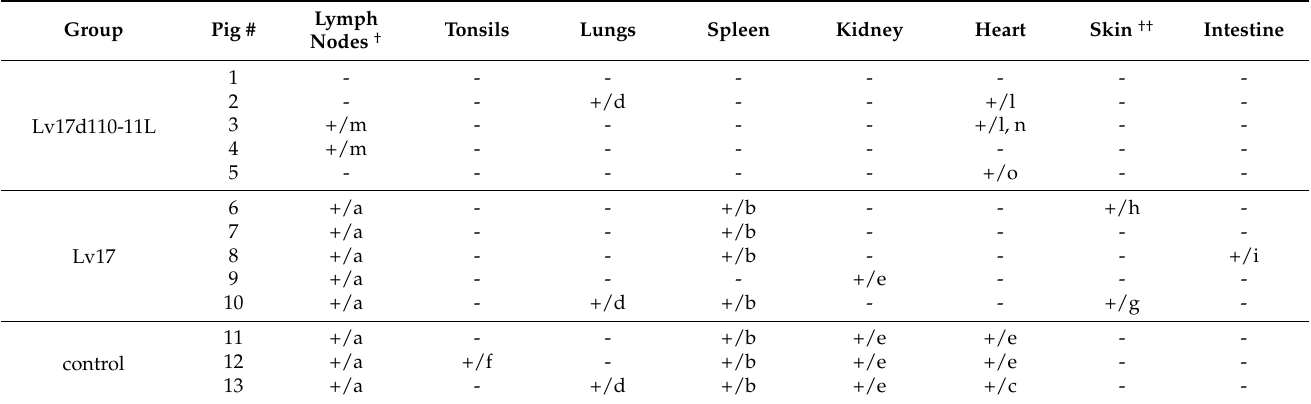
Table 6. Description of the macroscopic lesions observed in different groups injected with Lv17/WB/Rie1/d110-11L and Lv17/WB/Rie1 of African swine fever virus (ASFV) and challenge- infected with Armenia/07 of ASFV.